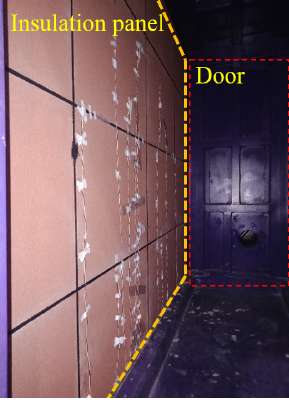
Materials 2021 , 14 , x FOR PEER REVIEW Figure 8. Inside view after the test. Figure 8. Inside view after the test.